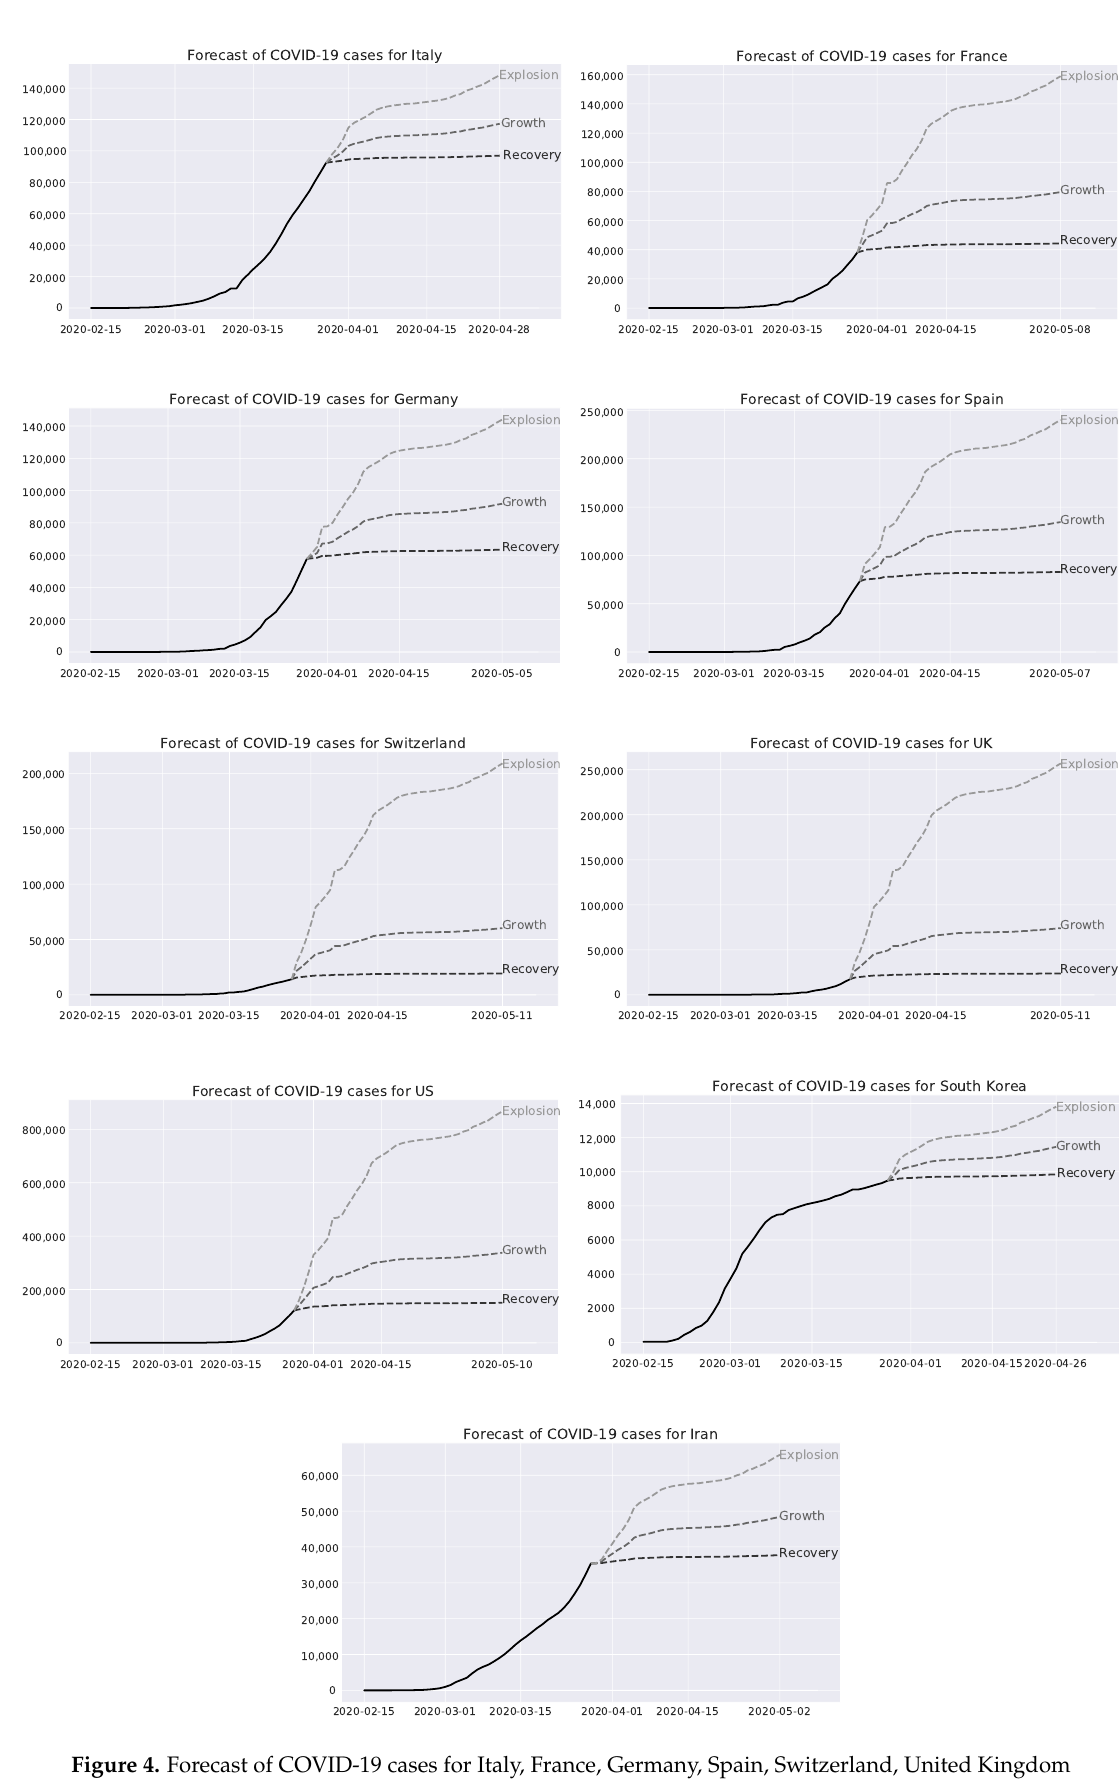
Figure 4. Forecast of COVID-19 cases for Italy, France, Germany, Spain, Switzerland, United Kingdom (UK), United States (US), South Korea, and